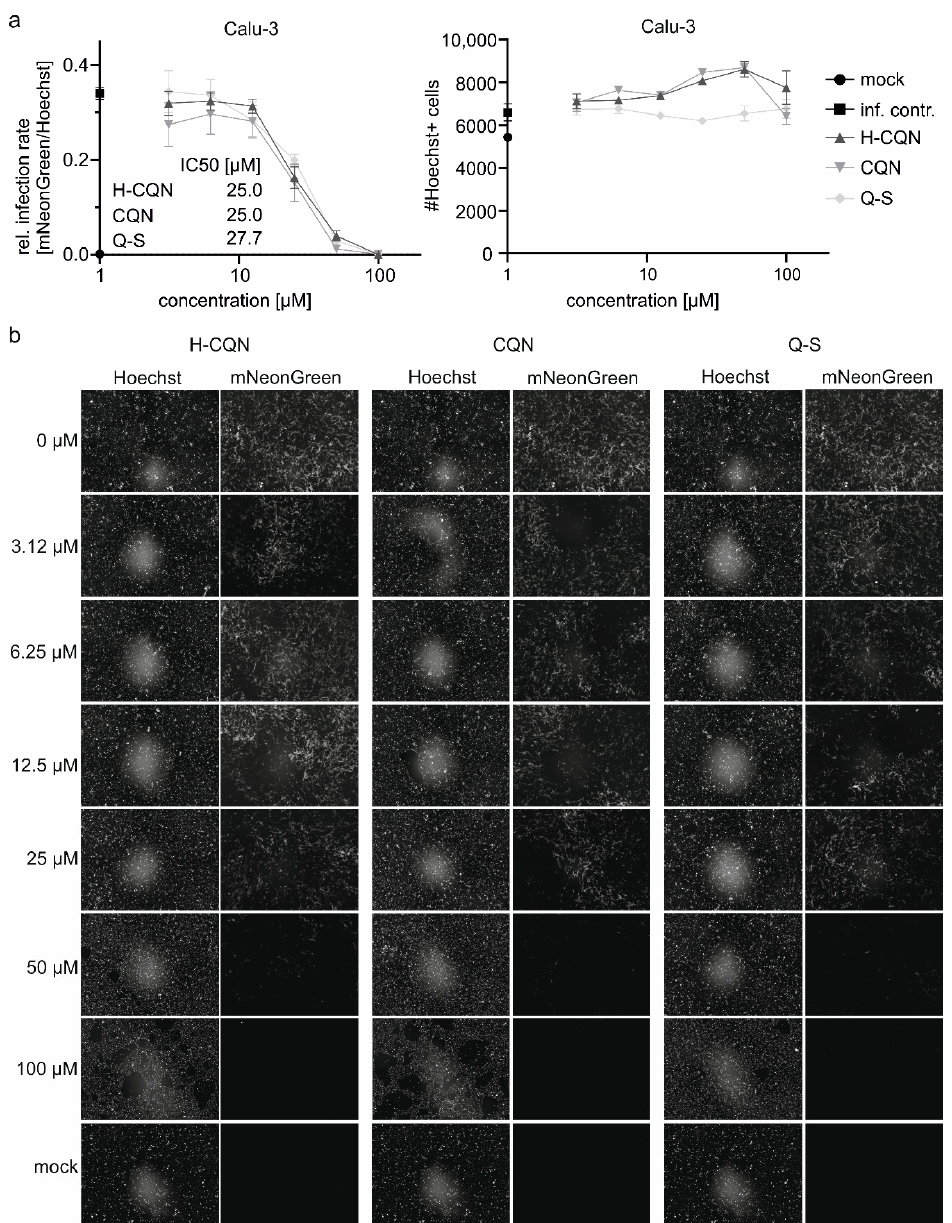
Figure 9. Antiviral activity of H-CQN, CQN, and quinine on SARS-CoV-2-mNG infection in Calu-3 cells. Cells were infected with SARS-CoV-2-mNG at an MOI of 0.2 for 1 h or mock-infected. Then the inoculum was removed, and the cells were treated with the indicated amounts of H-CQN, CQN, or Q-S. At 48 hpi, cells were fixed with 2% PFA and nuclei were stained with 1 µ g/mL Hoechst. The total amount of cells (Hoechst+) and infected cells (mNeonGreen+) were analyzed by automated microscopy. ( a ) Quantitative analyses of infection rates and the total number of cells for the treatment with the different compounds. Mean values and SEM are calculated from three independent experiments with triplicate infections. ( b ) Representative fluorescence microscopy images taken at 4-fold